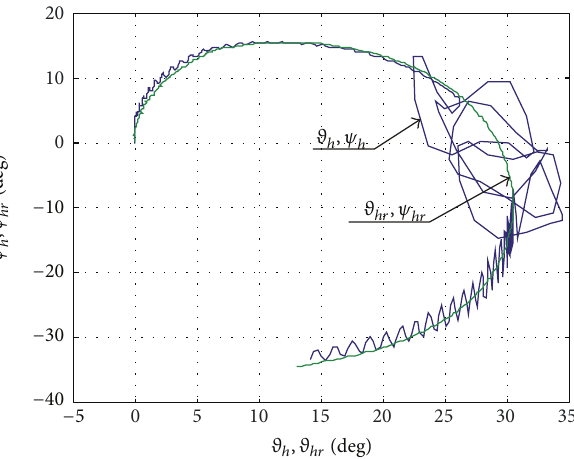
Figure 9: Real and desired trajectory of movement of the head axis for nonoptimum controls with the influence of disturbances.